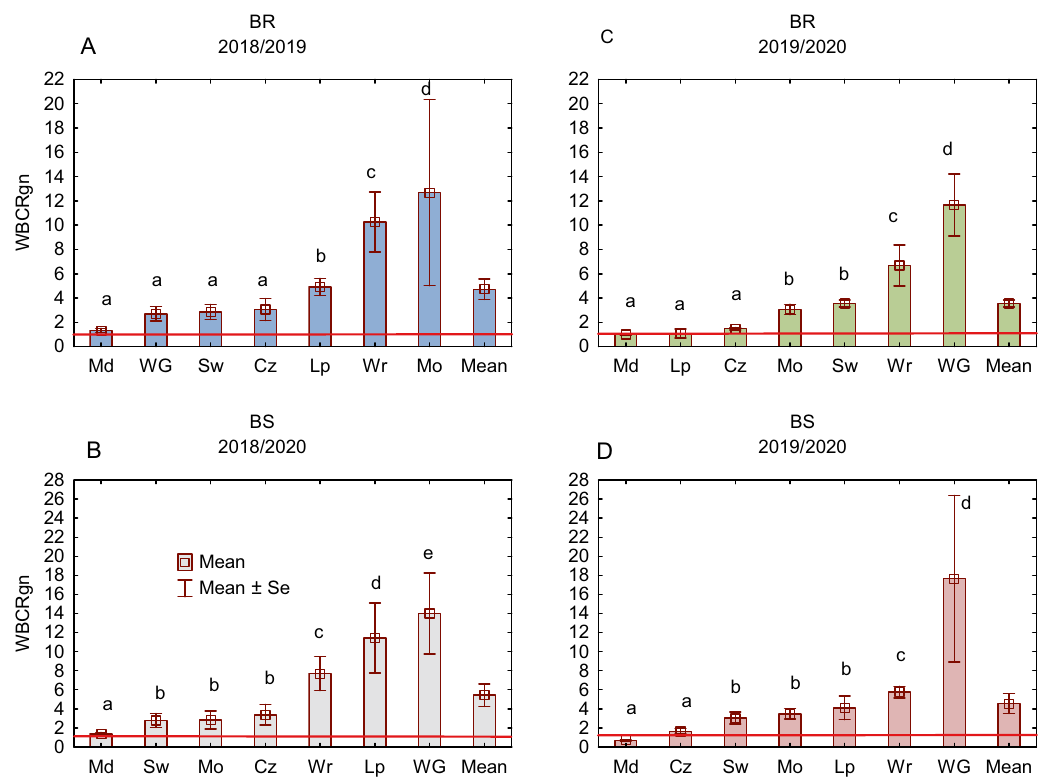
Figure 6. The competitive ratio for grain numbers (WBCRgn) between winter wheat and herbicide-resistant (BR)/susceptible (BS) blackgrass in the years of study for seven sites in Poland. Competitive ratio values < 1 indicate that blackgrass is more competitive than